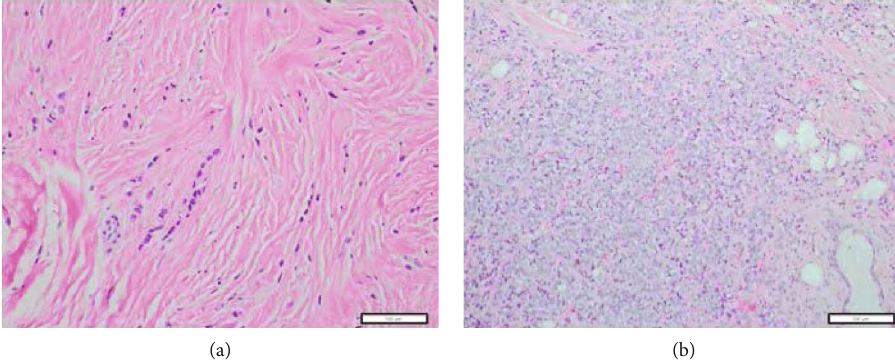
Figure 1: 20x hemotxylin and eosin stain of (a) invasive lobular cancer and (b) pleomorphic invasive lobular